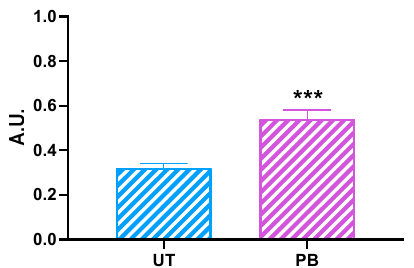
Figure 5. Proteasome chymotrypsin-like activity in untreated control (UT, n = 3) and phenobarbital- treated (PB, n = 4) cattle. Data are expressed as arithmetic means ± SD. A.U.: arbitrary unit. *** p < 0.001 (unpaired t -test).